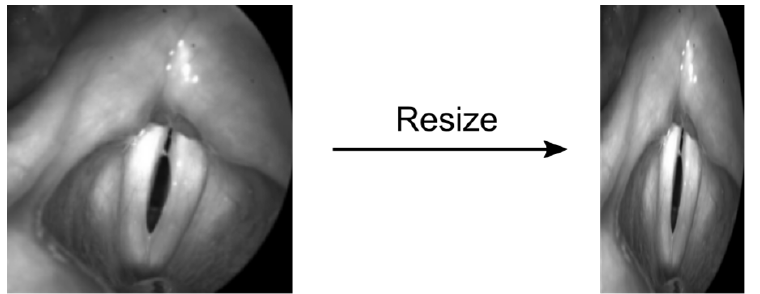
Figure 5. Potential induced deformations using the previously suggested resizing method by ref. [30].